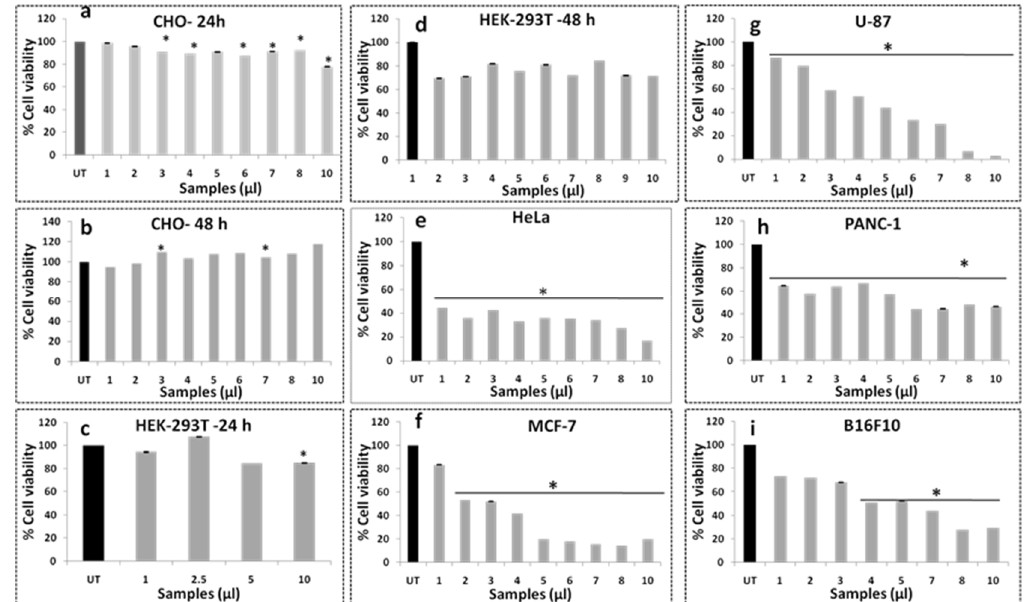
Figure 2. Cell viability of AgZE in normal and cancer cell line using MTT. The cell viability assay of different normal (24 h and 48 h) and cancer cell lines (48 h) incubated with AgZE using MTT reagent. The normal cell lines are: ( a ) CHO (24 h), ( b ) CHO (48 h), ( c ) HEK-293T (24 h), and ( d ) HEK-293T (48 h); the cancer cell lines are: ( e ) HeLa, ( f ) MCF-7, ( g ) U-87, ( h ) PANC-1, and ( i ) B16F10. There is dose-dependent increase in cytotoxicity of AgZE towards cancer cells compared to normal cells, indicating their anticancer activity (numerical values shows the amount of AgZE taken where 1 µL = 0.23 µg/mL of silver as per ICPOES study). Significant differences from untreated (UT) cells were observed (* p < 0.05).